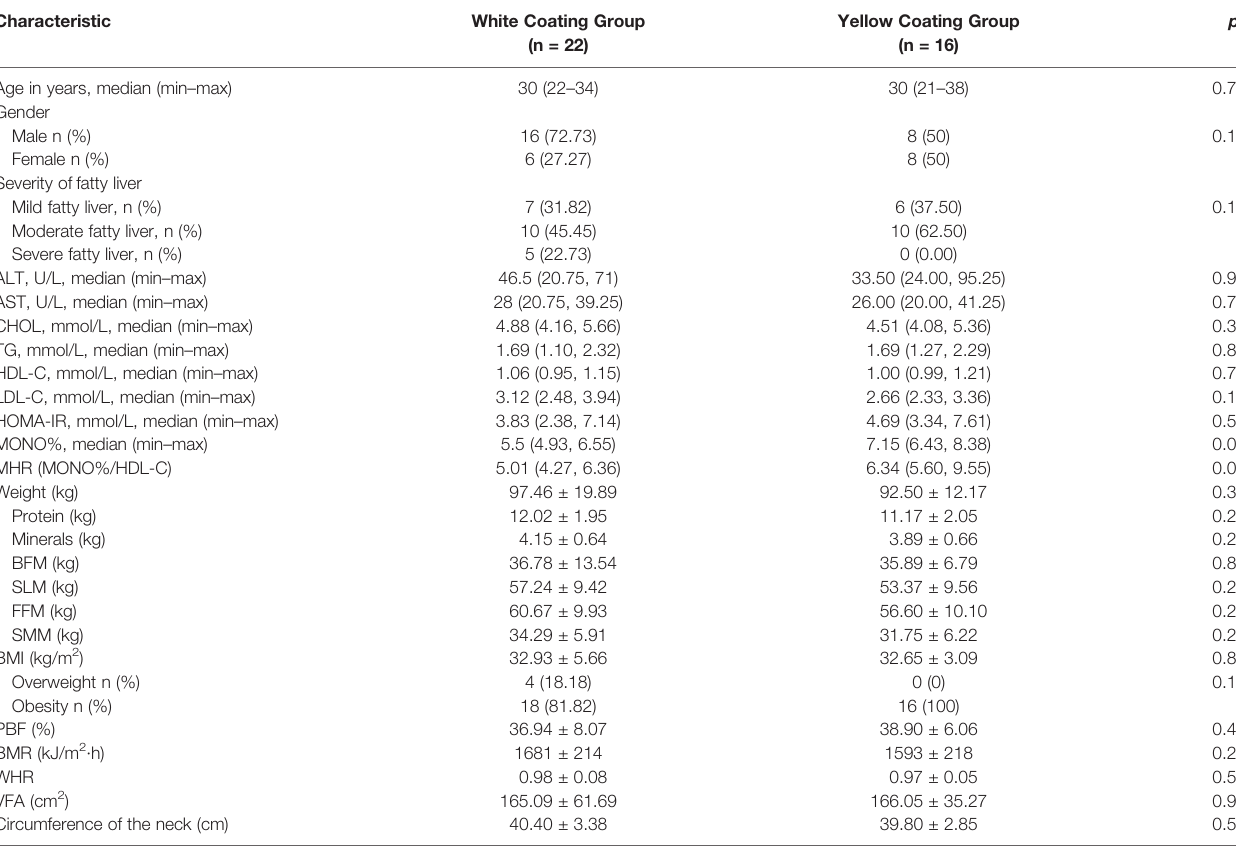
TABLE 3 | Characteristics of MAFLD patients in the two groups. Characteristic White Coating Group